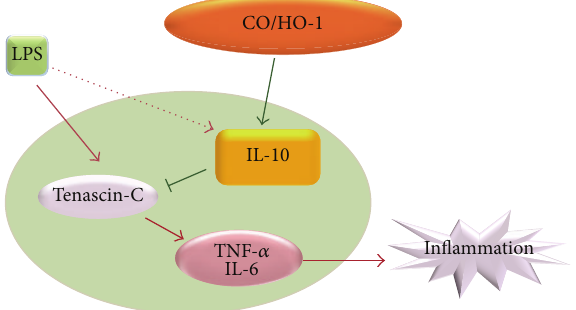
Figure 6: Schemata of the proposed CO/IL-10-dependent anti- inflammatory signaling pathway. Carbon monoxide increased IL- 10 expression and inhibited TN-C-induced inflammation in a septic mouse model in vivo and in vitro